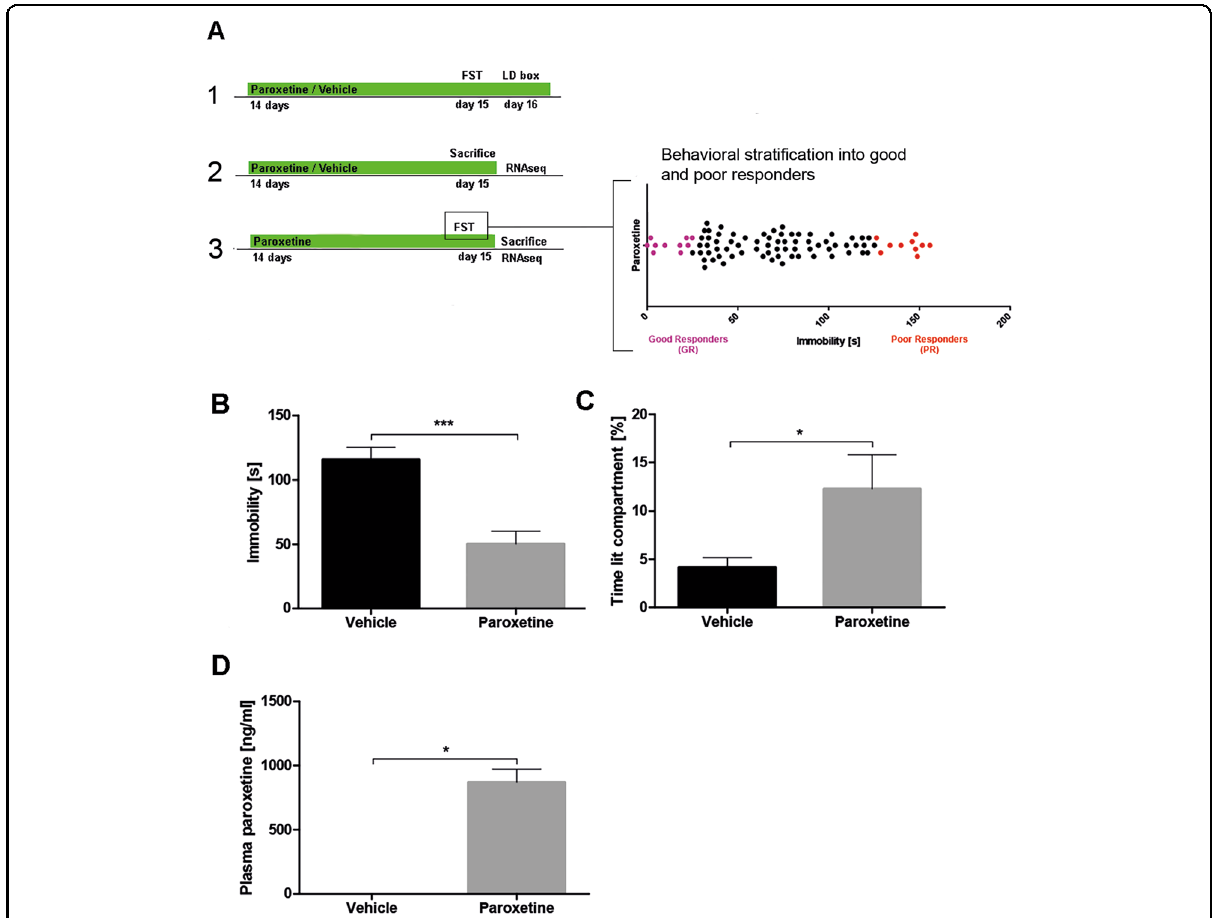
Fig. 1 Experimental approach and effects of paroxetine treatment on depression-like behavior. A Schematic overview of the experimental schedules to assess the impact of paroxetine treatment on behavior (panel 1, n = 20) and dentate gyrus transcriptome pro fi les in comparison to vehicle-treated animals (panel 2, n = 13). To identify the molecular signatures underlying response, we strati fi ed animals into good and poor treatment responder according to their behavioral outcome in the forced swim test (panel 3, n = 10 per subgroup good/poor responder). B Paroxetine treatment reduced immobility time ( T test, t = 4.7, df = 18, p = 0.0002) in the FST in comparison to vehicle treatment. C Paroxetine treatment increased the time spent in the lit compartment of the LD box ( T test, t = 2.2, df = 10, p = 0.0496). D Paroxetine plasma concentration was measured after treatment (Wilcoxon signed-rank test, p = 0.0313). FST forced swim test, LD light dark box, bars with mean and SEM. * p < 0.05; *** p <